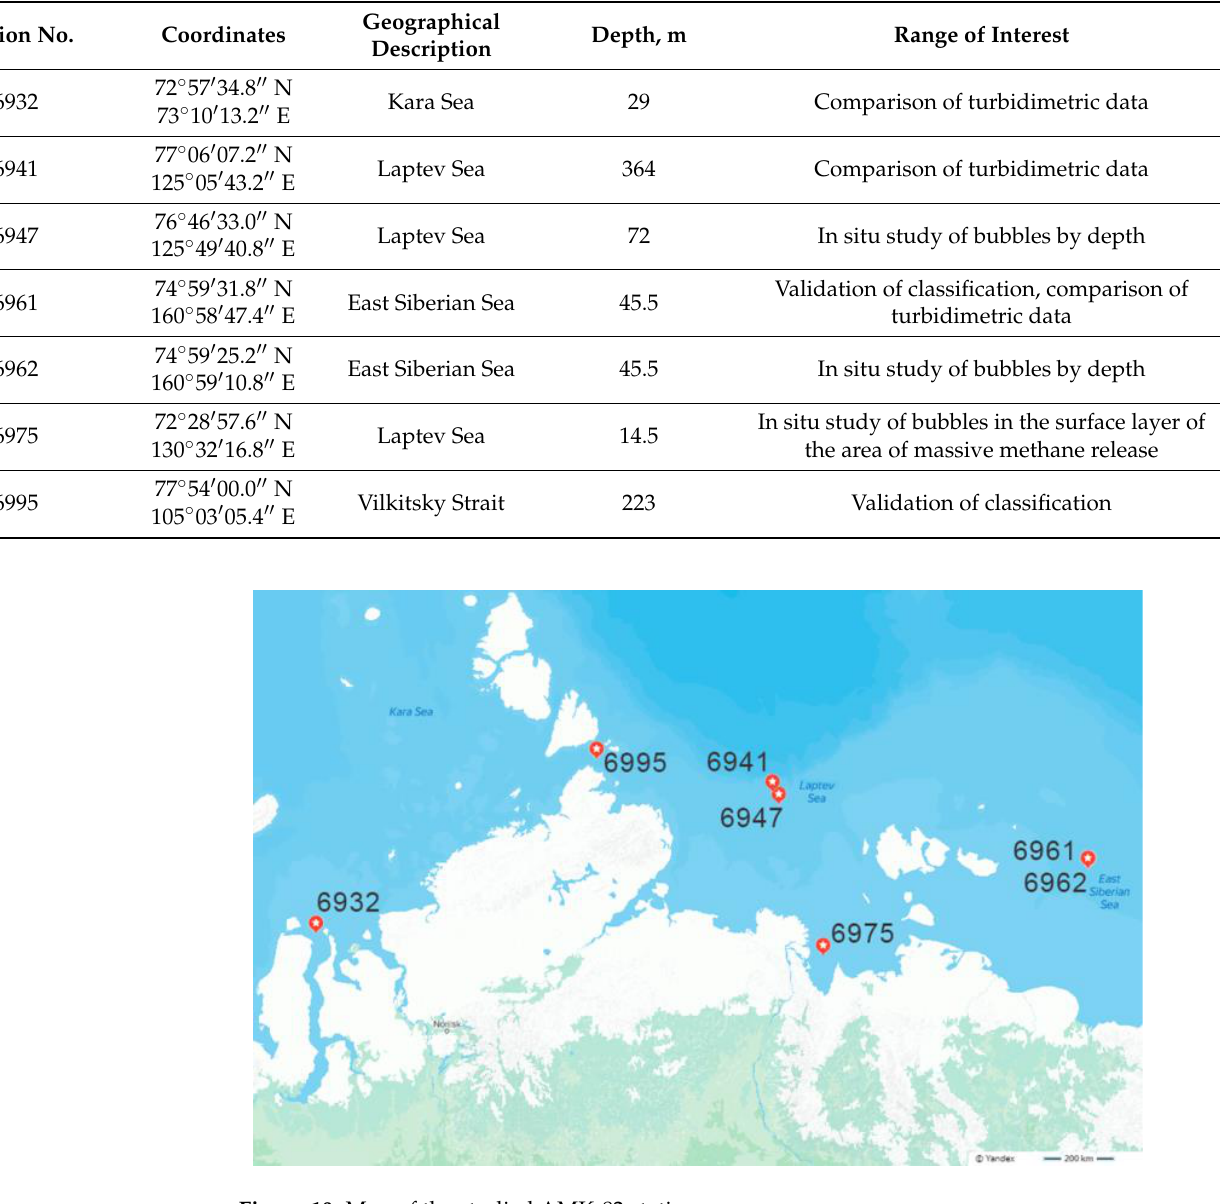
Table 4. General performance of the DHC probe.